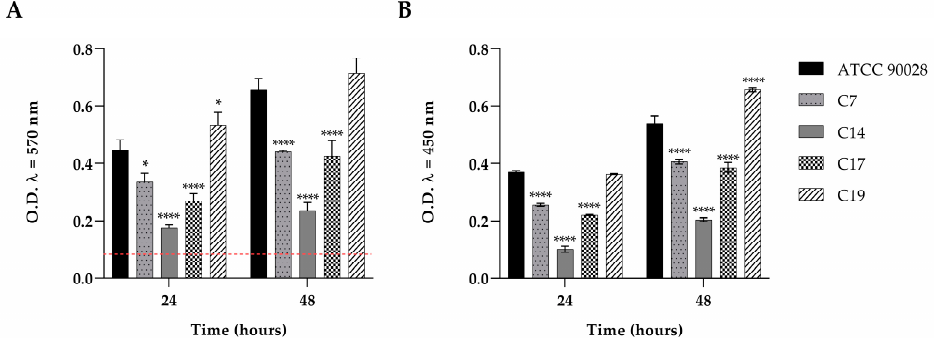
Figure 1. Panel ( A ): Comparison between the total biomass of biofilms of C. albicans ATCC90028 and C. albicans clinical isolates (C7, C14, C17, and C19) at 24 and 48 h. Red line represents ODcut (ODcut = mean of negative control with addition of 3 times). Panel ( B ): Comparison between the metabolic activities of the same strains at 24 and 48 h. Statistical significance: * p < 0.05, **** p < 0.0001 (Tukey’s test).